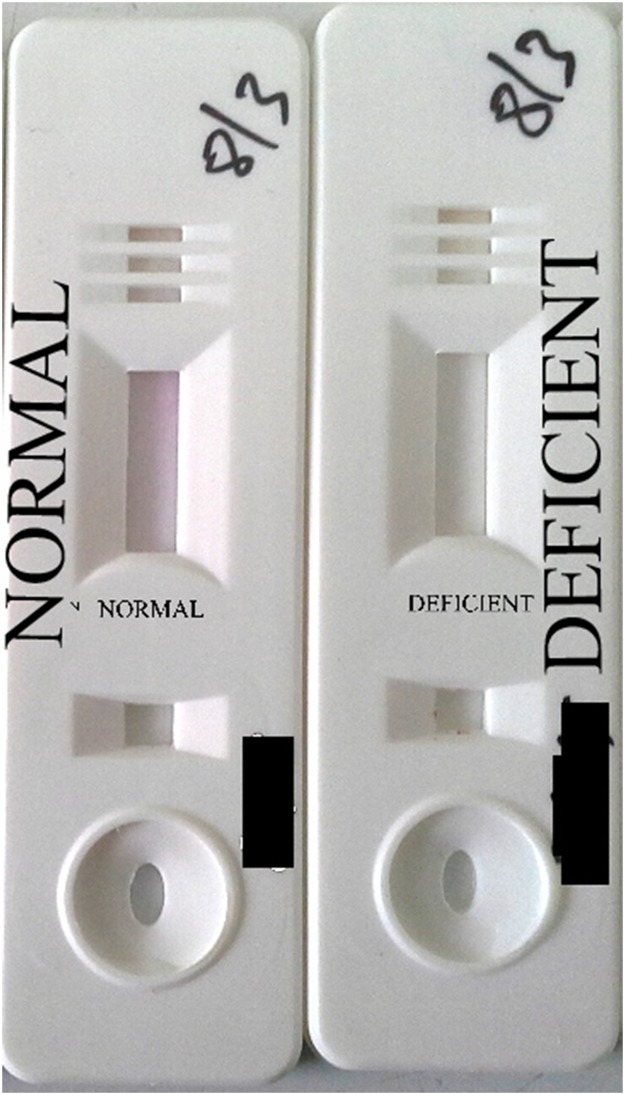

CareStart G6PD RDT screening kit with results interpretation.Results of kit labelled with NORMAL and DEFICIENT interpretation.